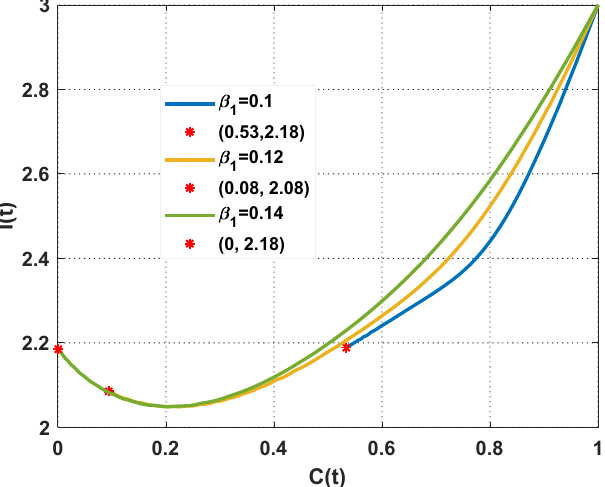
Figure 7. Phase portrait of the CICV model for the data given in Table 1 with 𝛽 (cid:2869) (cid:3404) 0.1,0.12 and 0.14 .